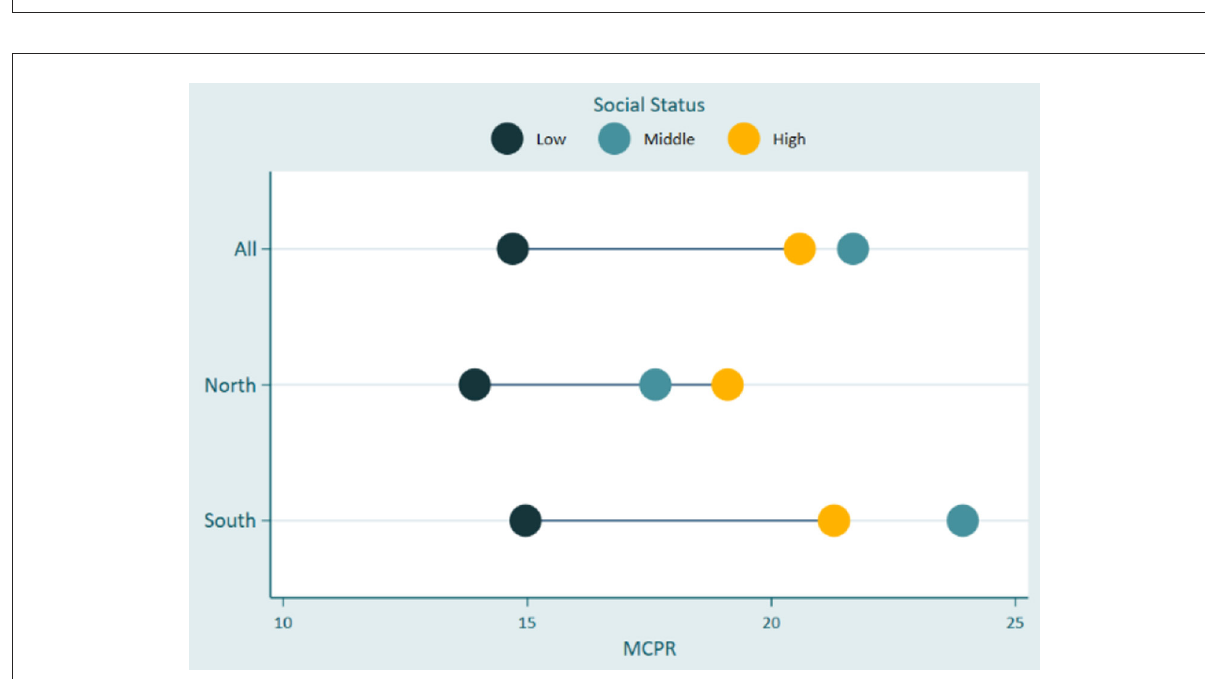
FIGURE3 Inequalities in contraceptives uptake by social